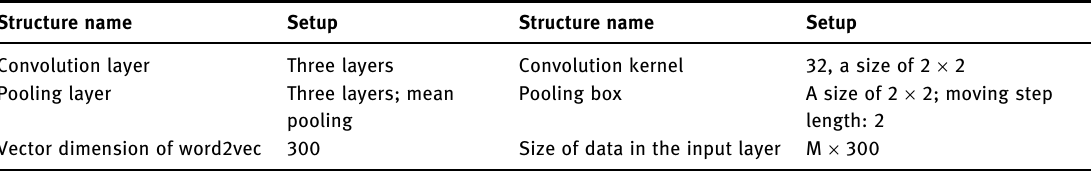
Table 2: The basic structural parameters of the classi fi cation